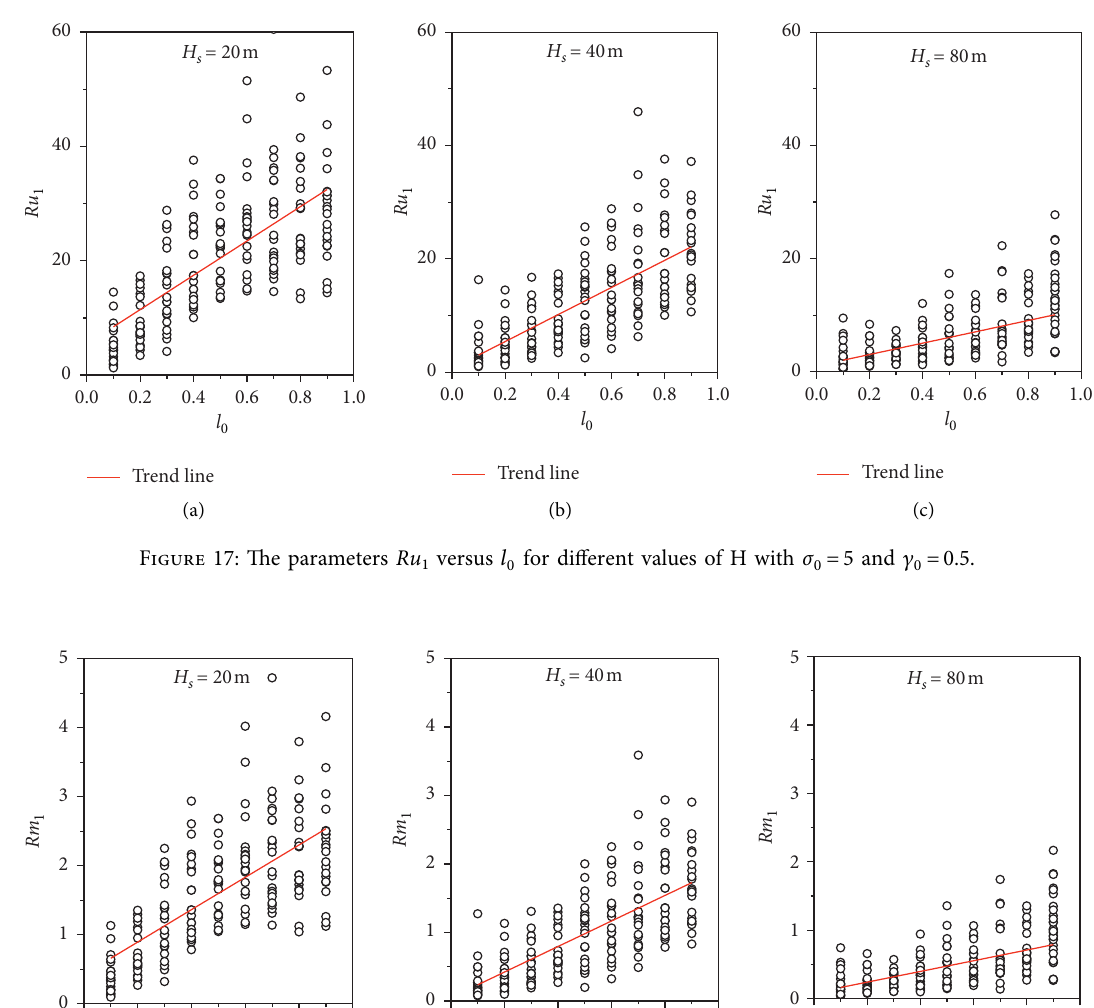
Figure 18: The parameters Rm